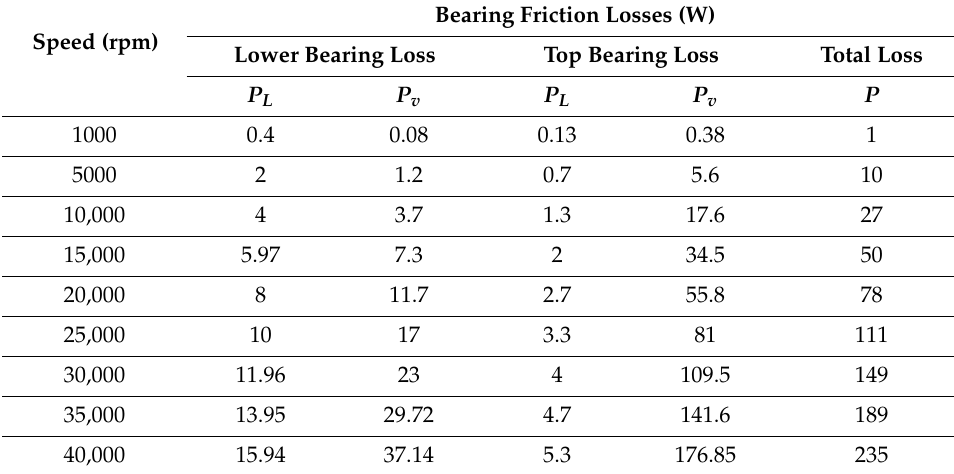
Table 4. Results of bearing standby loss